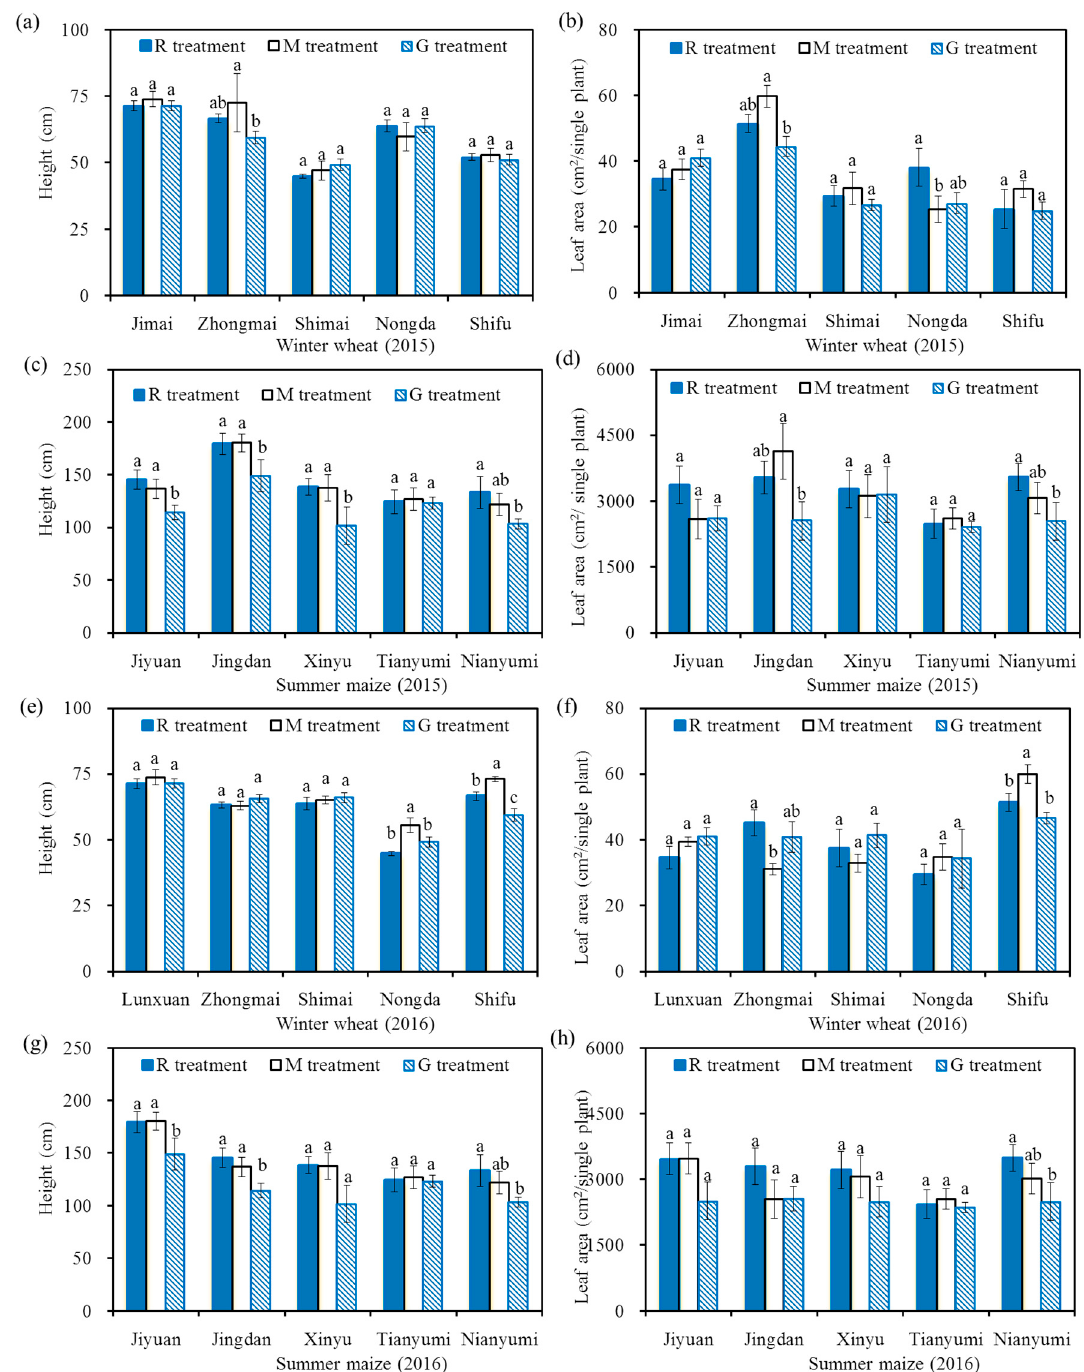
Figure 3. Height and leaf area of winter wheat and summer maize in 2015 and 2016, height of winter wheat in 2015 ( a ); leaf area of winter wheat in 2015 ( b ); height of summer maize in 2015 ( c ); leaf area of summer maize in 2015 ( d ); height of winter wheat in 2016 ( e ); leaf area of winter wheat in 2016 ( f ); height of summer maize in 2016 ( g ); leaf area of summer maize in 2016 ( h ). Note: Different letters on the top of the histogram indicate significant differences among the three treatments for each variety ( p < 0.05).